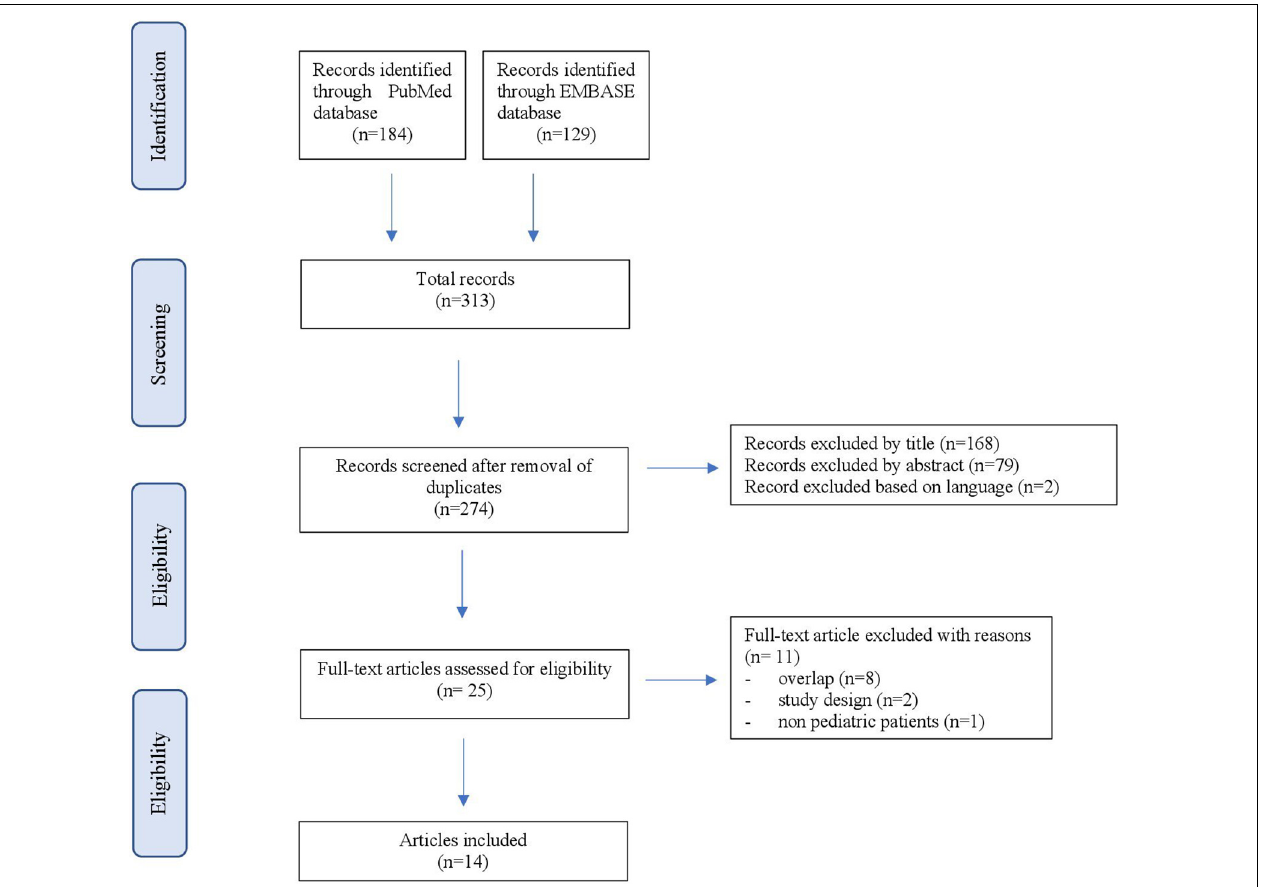
FIGURE 1 | PRISMA